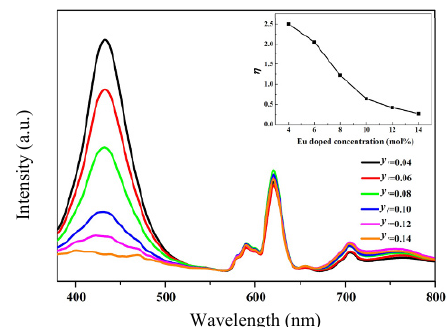
Fig. 8 Decay curves of Ba 0.79 Al 10.9 O 17.14 :0.04Eu, y Li + ( y = 0.04–0.14) monitored at 431